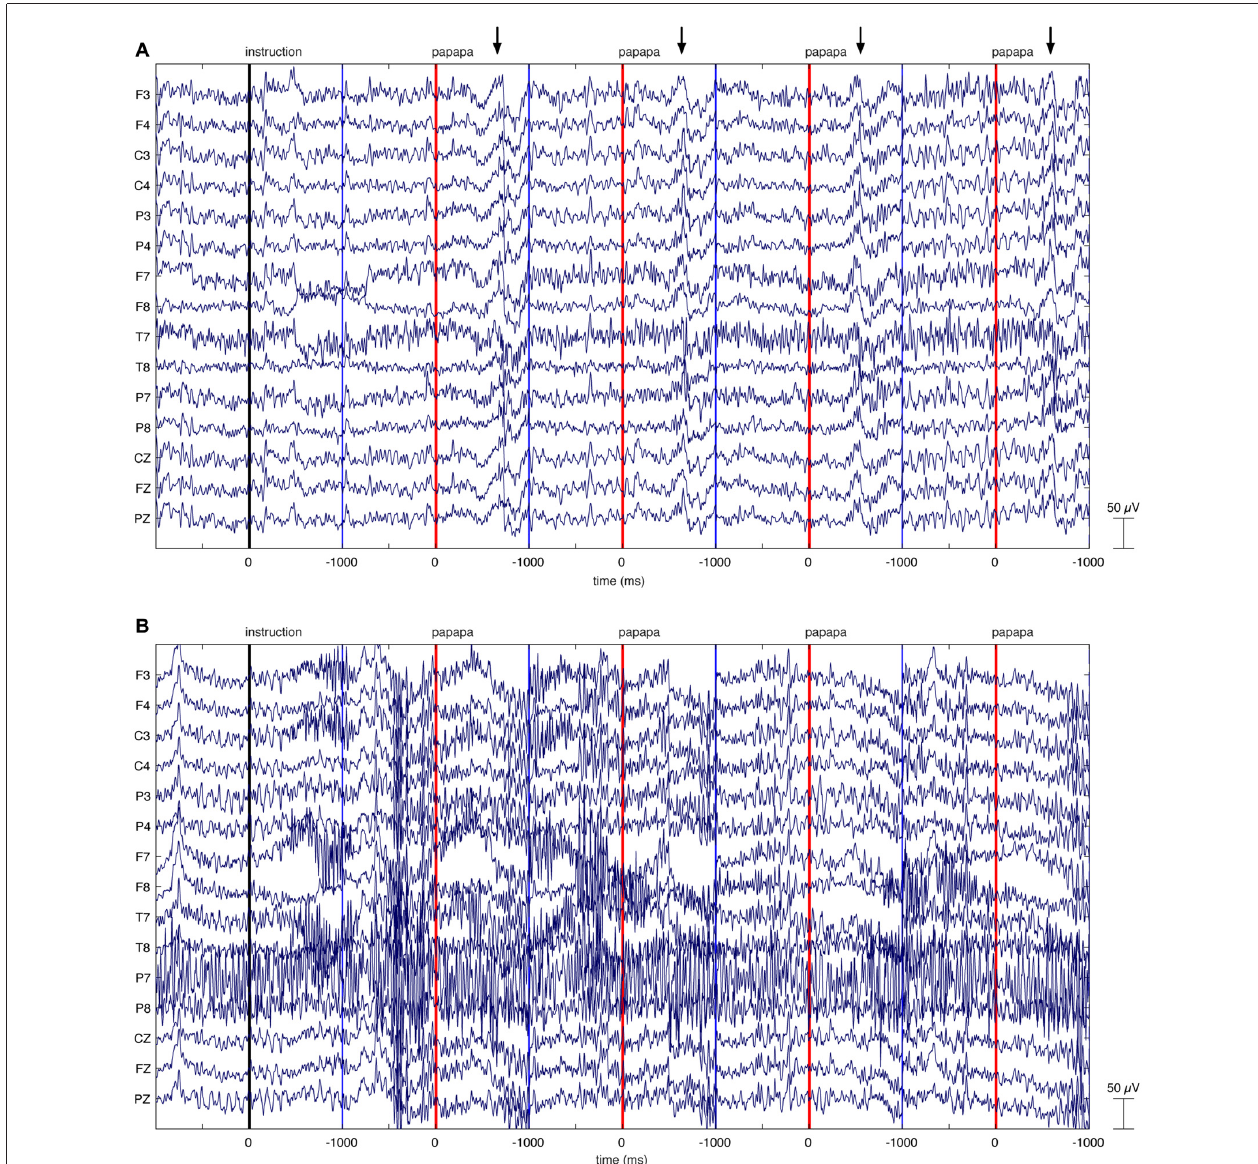
FIGURE 3 | Individual EEG data. The figure illustrates EEG recordings of two patients with Parkinson’s disease (PD), showing the first four papapa trials of the experiment. The onset of the visual cue ( papapa ) is represented by a red line. Epochs of EEG data have been extracted between − 1000 and 1000 ms relative to the onset of the cue. The upper recording (A) displays artifacts related to overt speech, starting around 500 ms after onset of the cue (marked by arrows). As these artifacts started with speech onset, the recording was included in the final data analysis. The lower recording of another patient with PD (B) shows massive high-frequency artifacts due to muscular activity. This recording was excluded from the final data